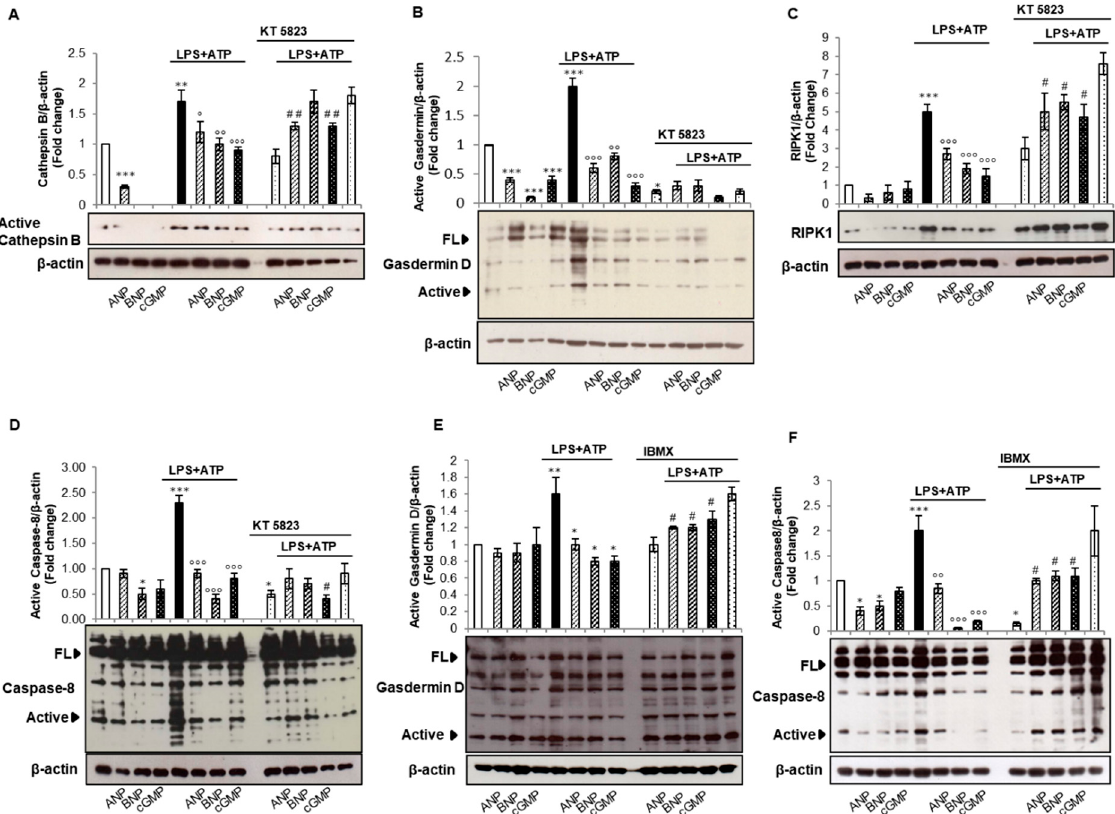
Figure 5. cGMP but not PKG-I is involved in non-canonical and alternative inflammasome activation. THP-1 cells were pre-treated for 10 min with ANP (10 − 8 M) or BNP (10 − 8 M) or cGMP (100 µ M 8-Br-cGMP) in the absence or presence of LPS (10 µ g/mL for 20 min) + ATP (5 mM for 40 min). When KT-5823 (1 µ M) or 3-isobutyl-1-methylxanthine (IBMX) (10 µ M) were used, they were added 1 h before ANP, BNP, or 8-Br-cGMP treatment. Cell lysates were immunoblotted for active Cathepsin B ( A ), Gasdermin D ( B , E ), RIPK1 ( C ), or Caspase-8 ( D , F ). Protein loading was assessed by re-probing the blots with an anti- β -actin antibody. One representative image is shown. Representative western blots images are shown. Histograms of densitometric quantification. Bars represent the ratio between respective protein and β -actin band intensity. Untreated cells were used as control and assumed as 1. All histograms indicate mean ± SD of at least n = three independent experiments, each one tested in triplicate. * p < 0.05, ** p < 0.01, *** p < 0.001 versus untreated cells; ° p < 0.05, °° p < 0.01 and °°° p < 0.001 versus LPS + ATP treated cells; # p < 0.05 versus KT-5823 + LPS + ATP treated cells.